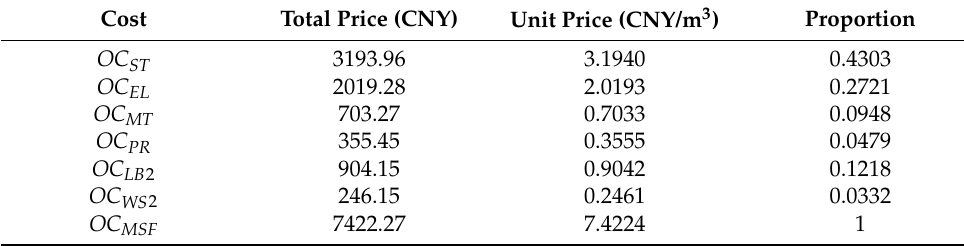
Table 6. OT-MSF system cost ratio table.